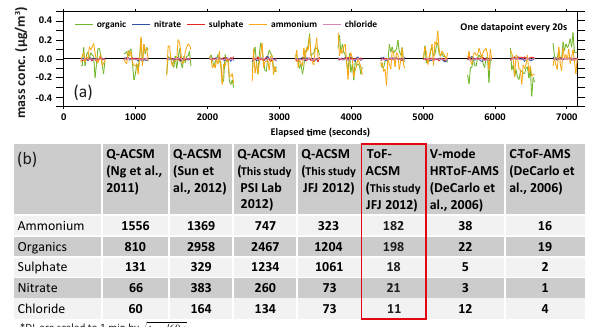
Fig. 4. (a) Signals of filtered air (in µgm − 3 ) recorded with an aver- aging time of 20s. During the gaps in the time series the background signal was monitored. Green: organics, red: sulphate, blue: nitrate, orange: ammonium, pink: chloride. (b) Overview over the 1min de- tection limits in ngm − 3 (3- σ ) of the ToF-ACSM equipped with the SGE detector (red box), Q-ACSM, HR-ToF-AMS in V-mode and